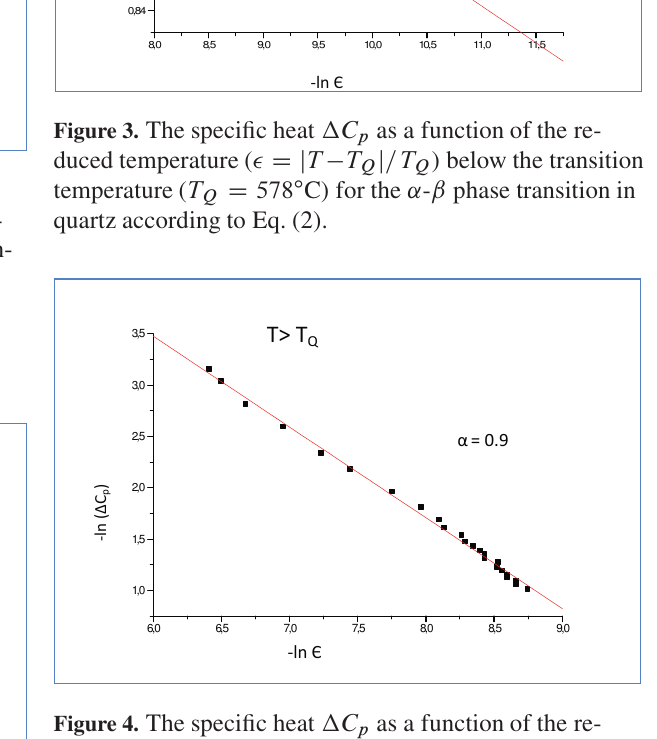
Figure 4. The specific heat (cid:3)C p as a function of the re- duced temperature .(cid:4) D j T (cid:2) T Q j =T Q / above the transition temperature ( T Q D 578 ı C) for the ˛ - ˇ phase transition in quartz according to Eq. (2). below T Q (Table 1), were renormalized according to the Fisher renormalization